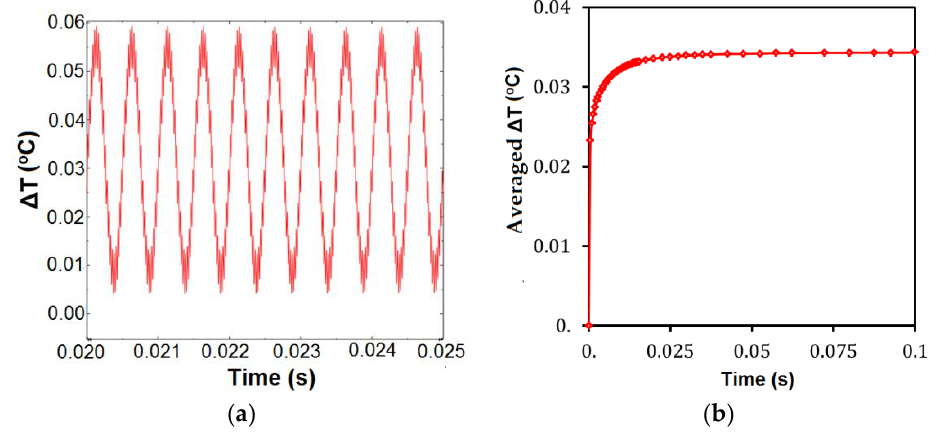
Figure 4. ( a ) A typical temperature increase profile of the nano-strip center ( f = 2000 Hz). ( b ) The average temperature increase of the nano-strip center versus the simulation time.